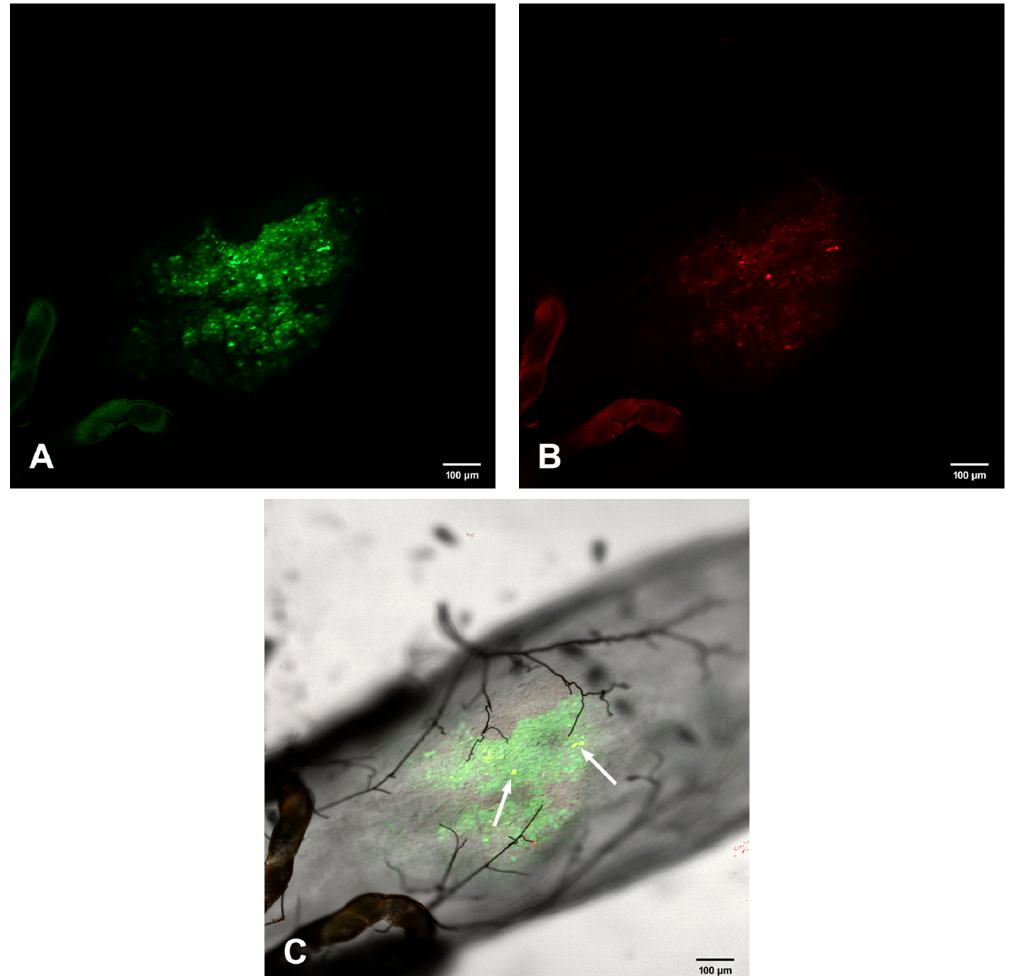
Figure 6. Confocal microscopic analysis of SINV-GFP accumulations and EC specific FMRFamide-TX Red immunoreactivity in PMG-m of mosquito #2 on day 7 p.i. ( A ) GFP accumulations indicating SINV replication. ( B ) FMRFamide immunoreactive ECs. ( C ) Bright-field background and overlay of ( A , B ) demonstrating the yellow color (white arrows) observed when SINV and EC colocalize. 200×.